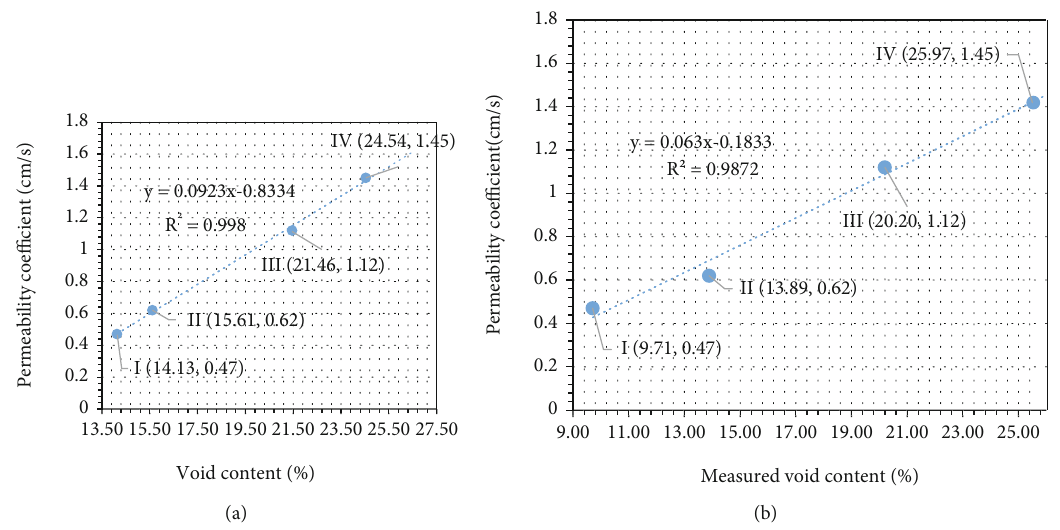
Figure 5: Size distribution of voids.